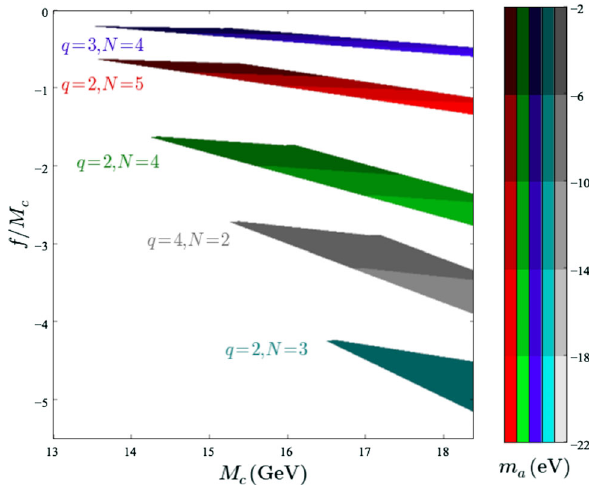
Fig. 3 Range of parameters for a DM ALP of mass m a ≤ 10 − 2 eV (axions saturating the DM relic density are found in colored regions, all axes are